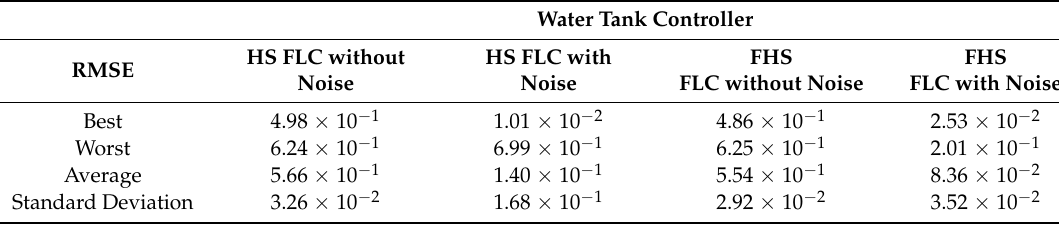
Table 10. Results obtained from the water tank controller by HS and FHS